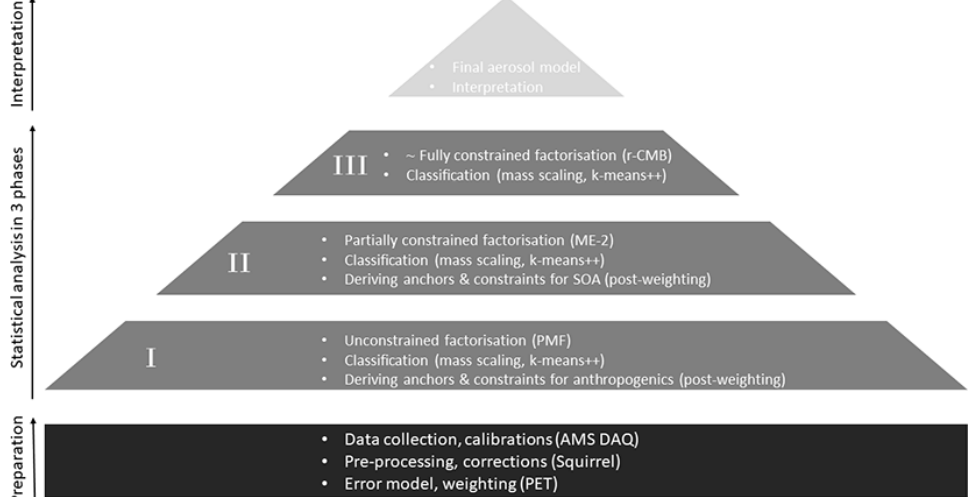
Figure 2. A flowchart illustrating the analysis using combined methodology. After initial data collection and preparation, statistical analysis is performed in three phases (P-I to P-III). Each phase limits the freedom given to factorisation from completely free (PMF) to nearly fully constrained (r-CMB). Finally, we evaluate and interpret the r-CMB model from an aerosol chemical